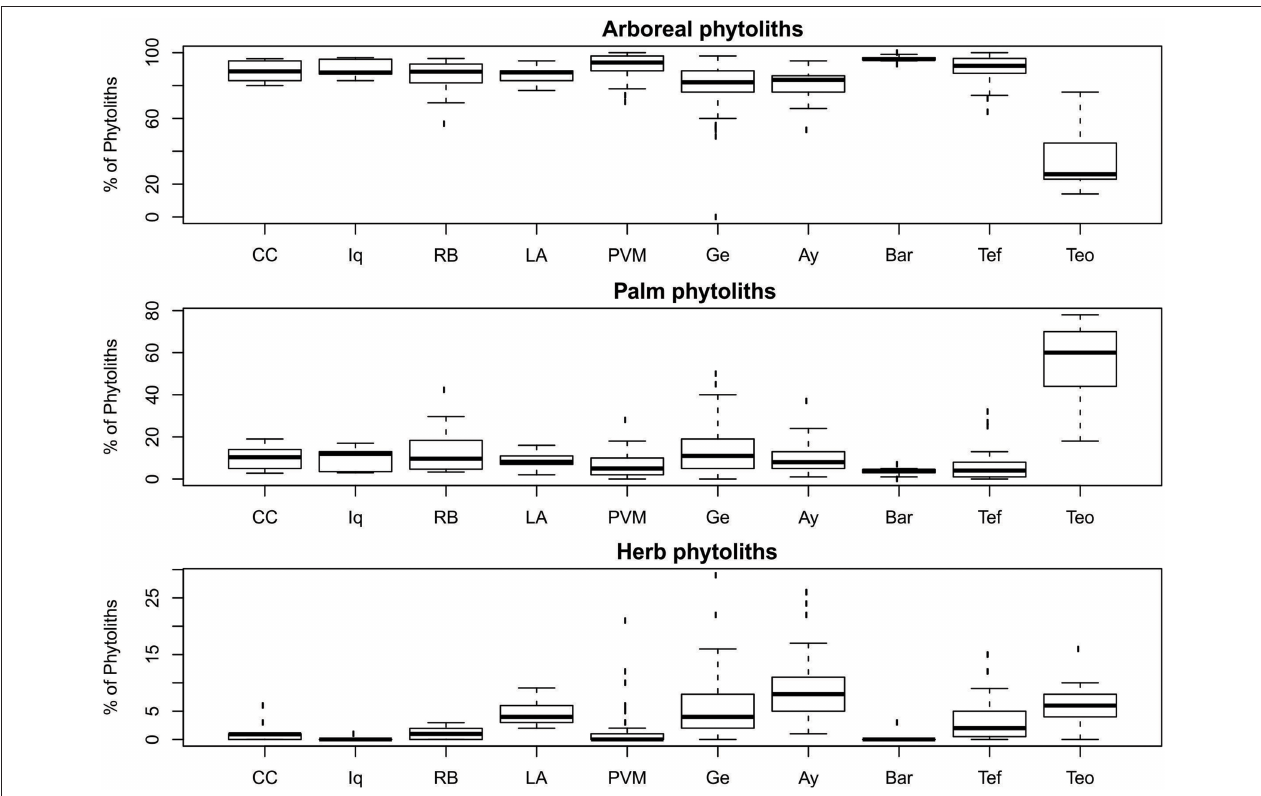
FIGURE 4 | Phytolith assemblages of total samples from each region surveyed. Region codes are as follows: Cocha Cashu (CC), Iquitos (Iq), Rio Branco (RB), Los Amigos (LA), Porto Velho–Manaus (PVM), Lake Gentry (Ge), Lake Ayauchi (Ay), Barcelos (Bar), Tefé (Tef), Teotônio (Teo). See Table 1 for total number of samples analyzed from each